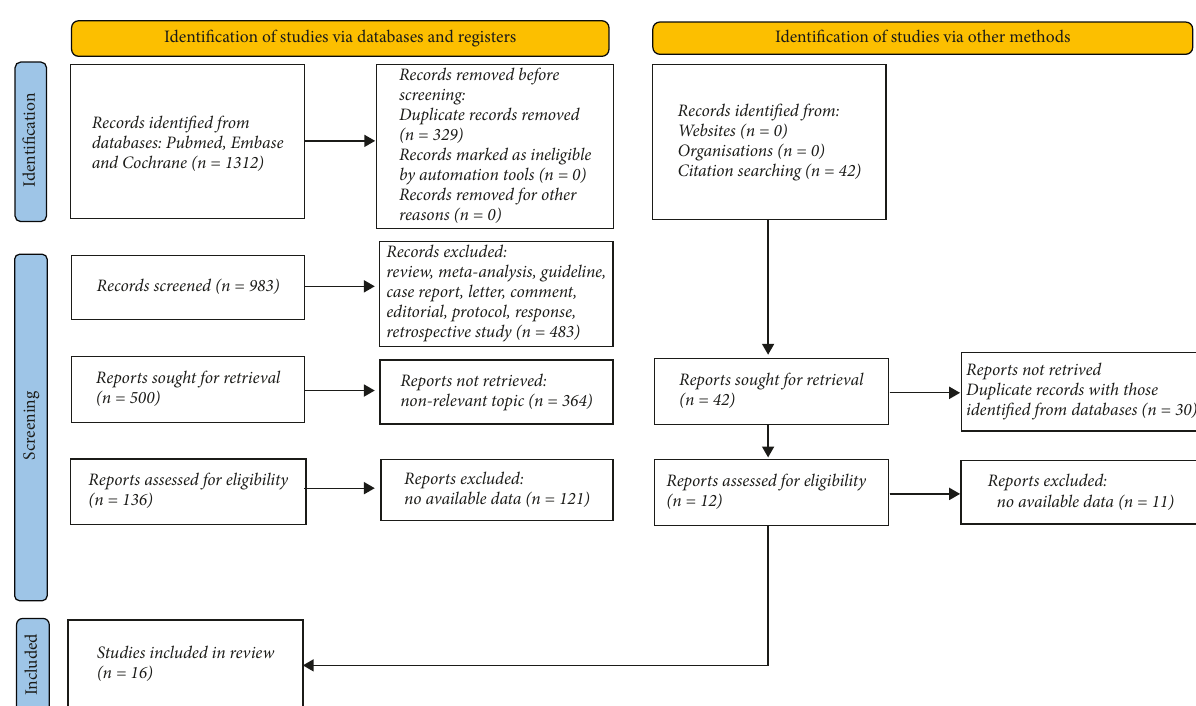
Figure 1: Flowchart of selection of